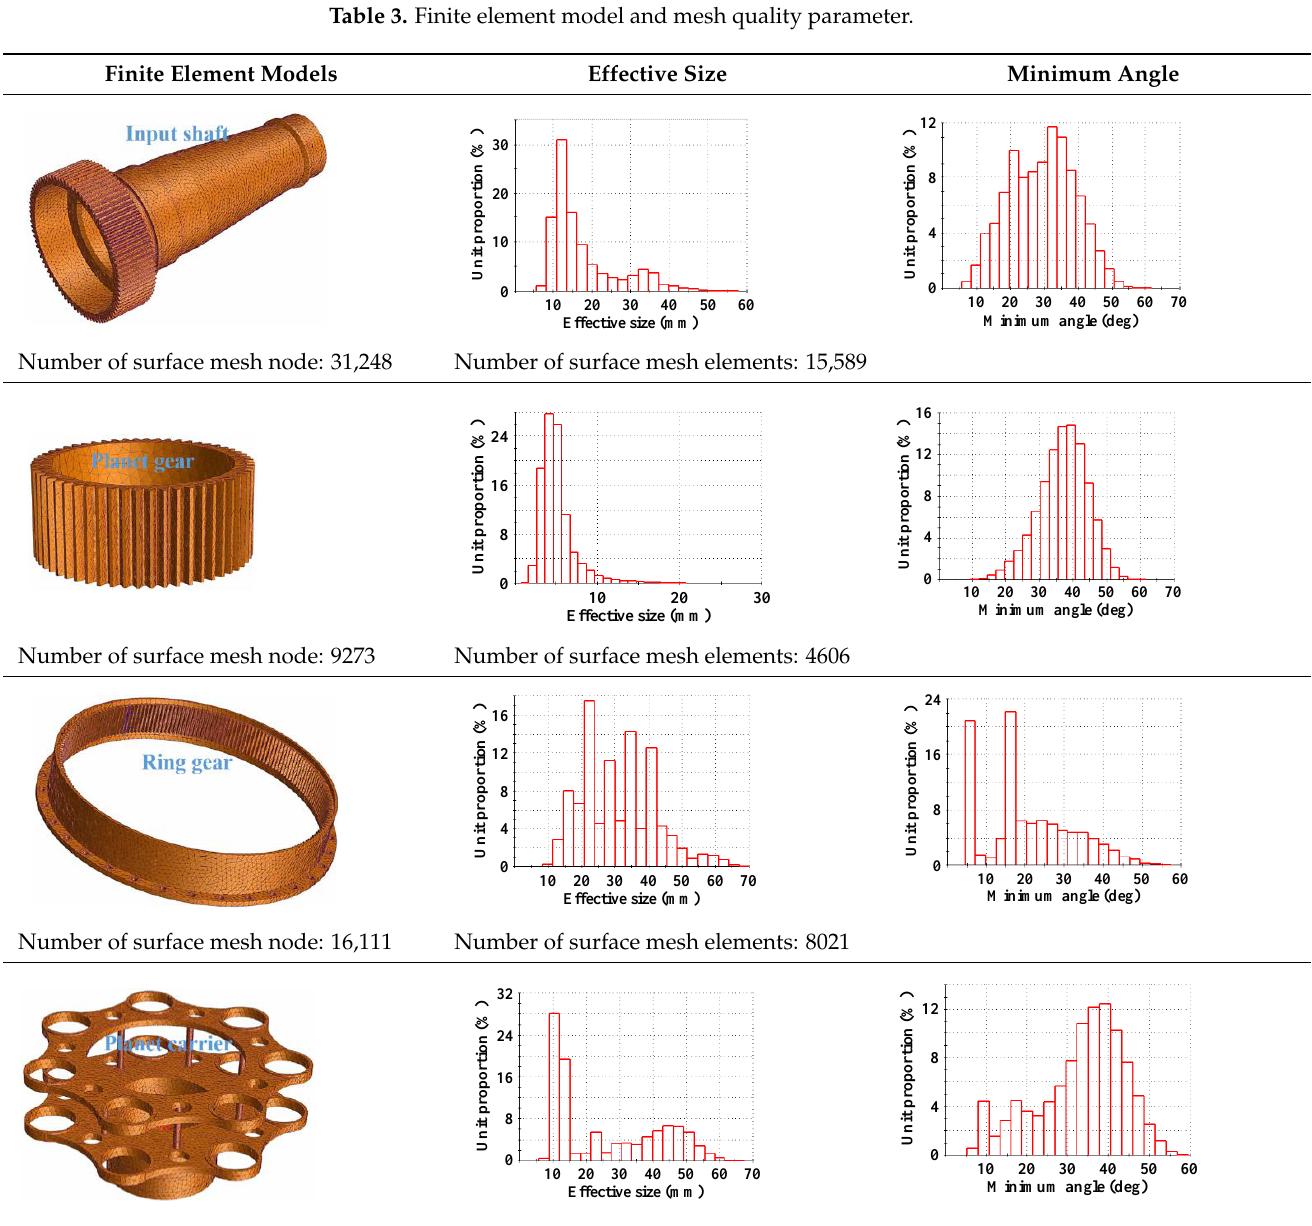
Table 3. Finite element model and mesh quality parameter.